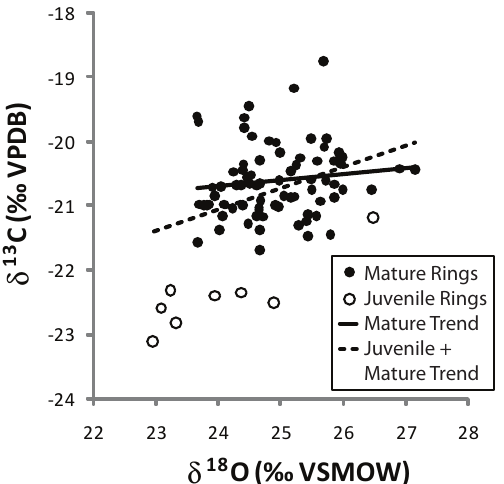
Figure 3. Correlation analysis of dual-isotope annual data set. δ 18 O and δ 13 C were significantly positively correlated (dashed trendline; Pearson’s R = 0.36, P <0.001, n = 86). However, if the first 4–8 “juvenile” tree rings (hollow circles) are removed from analysis, the remaining samples (filled circles) are not correlated (solid trendline; Pearson’s R = 0.14, P = 0.22, n = 78).